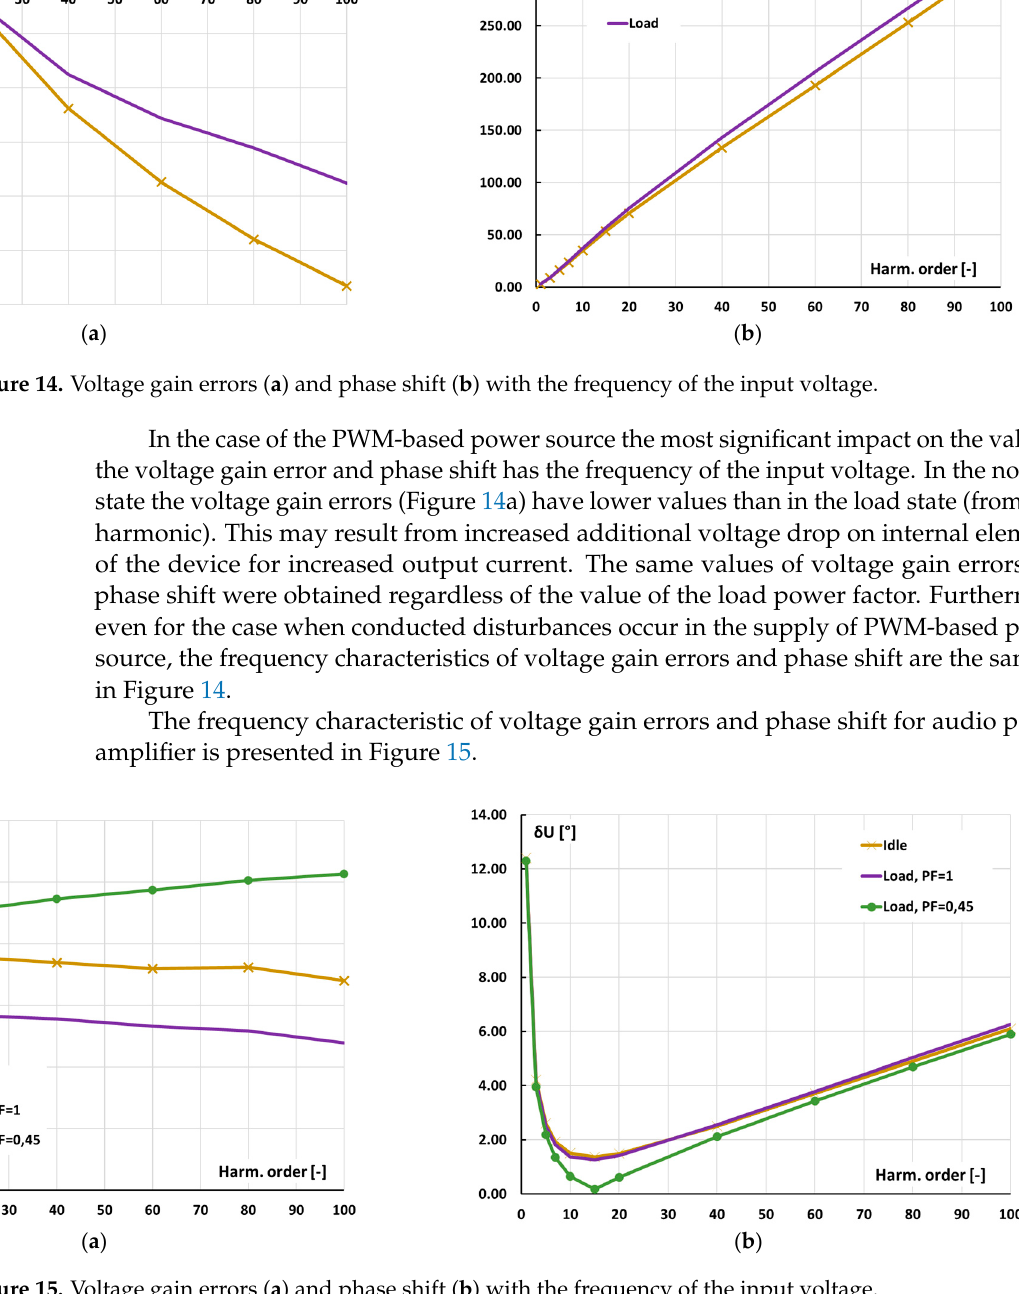
Figure 15. Voltage gain errors ( a ) and phase shift ( b ) with the frequency of the input voltage.